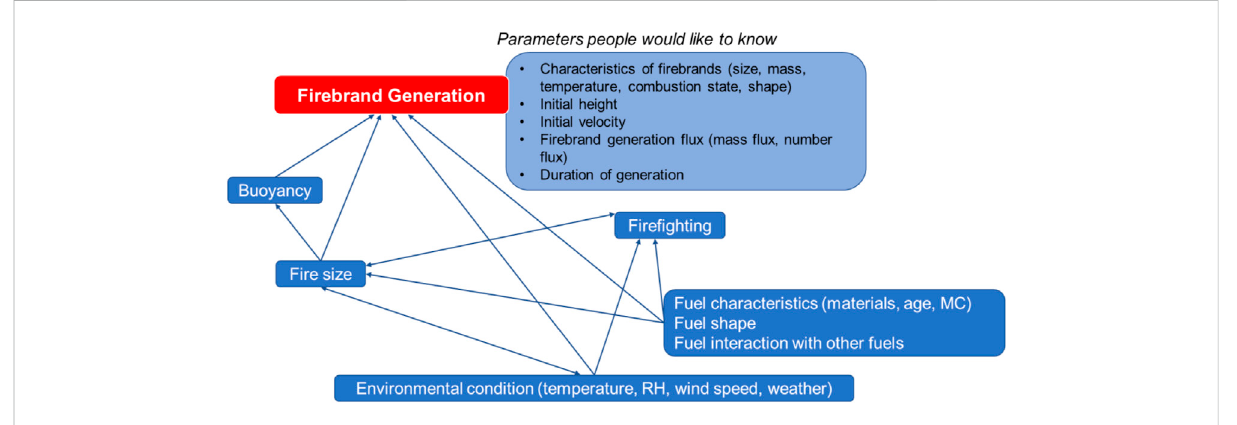
FIGURE 7 A listing of important factors that in fl uence fi rebrand generation